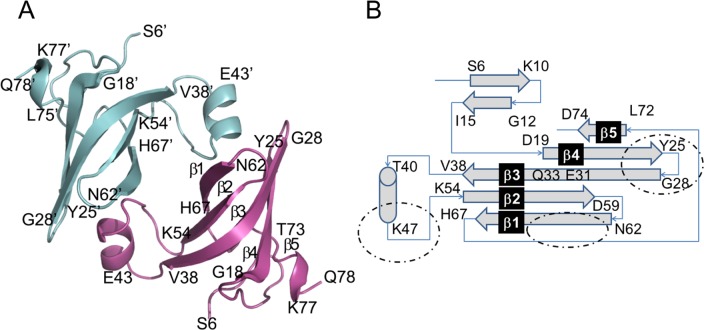
Crystal structure of Hva1.(A) The two monomers of the asymmetric unit are distinguished in cyan and magenta. Regions corresponding to β-strands and α-helix are shown as arrows and a coil, respectively. The β-strands that form the twisted sheet are labelled as β1–5 in the magenta model of this figure with β5 not represented in the arrow format to improve clarity. Overall, the architecture of Hva1 is very ordered and the two monomers are associated with each other via an extensive interface. (B) Connecting topology of the various secondary structural motifs of Hva1. The two monomers of the asymmetric unit are distinguished in cyan and magenta. Arrows represent β-strands which are labelled as indicated in (A). The regions that form the monomer-monomer interface are highlighted by dotted circles.